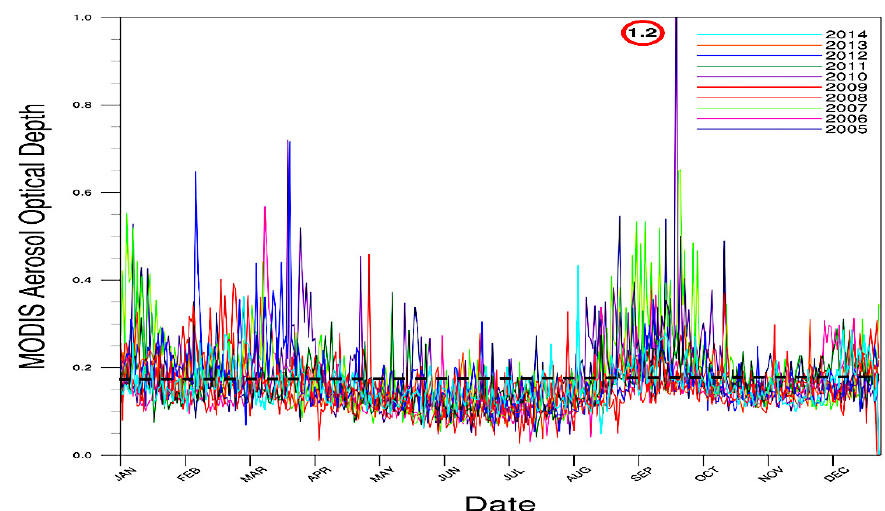
Figure 2. Aerosol Optical Depth daily averaged time series derived from the MODIS instrument aboard TERRA and AQUA satellites for the period of 2005 to 2014. Different colors represent the individual years, while the black line is the median of all annual time series.